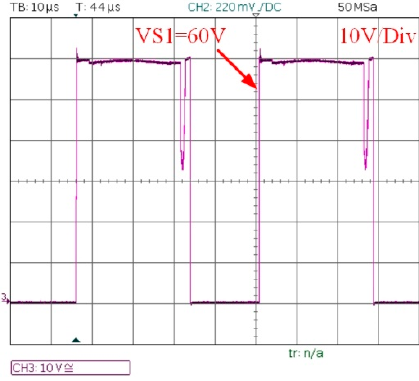
Figure 13. Stress on Switch 1. It is the same for all switches.